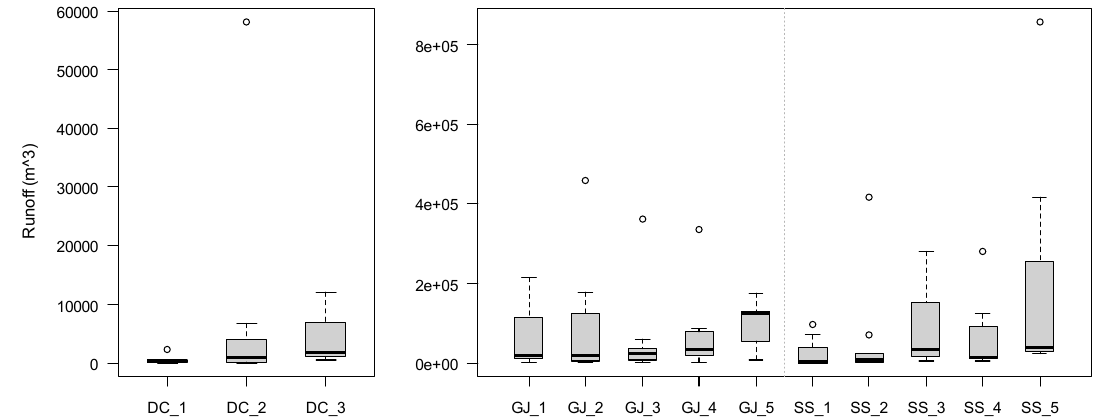
Figure 3. The runo ff at each monitoring site during rainy days over the monitoring period. Figure 3. The runoff at each monitoring site during rainy days over the monitoring period.